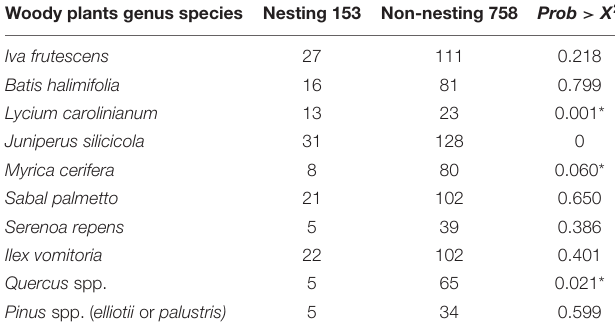
TABLE 2 | Records of presence of 10 species of woody plants observed during land surveys of Diamondback Terrapin nesting and non-nesting habitats in northeast